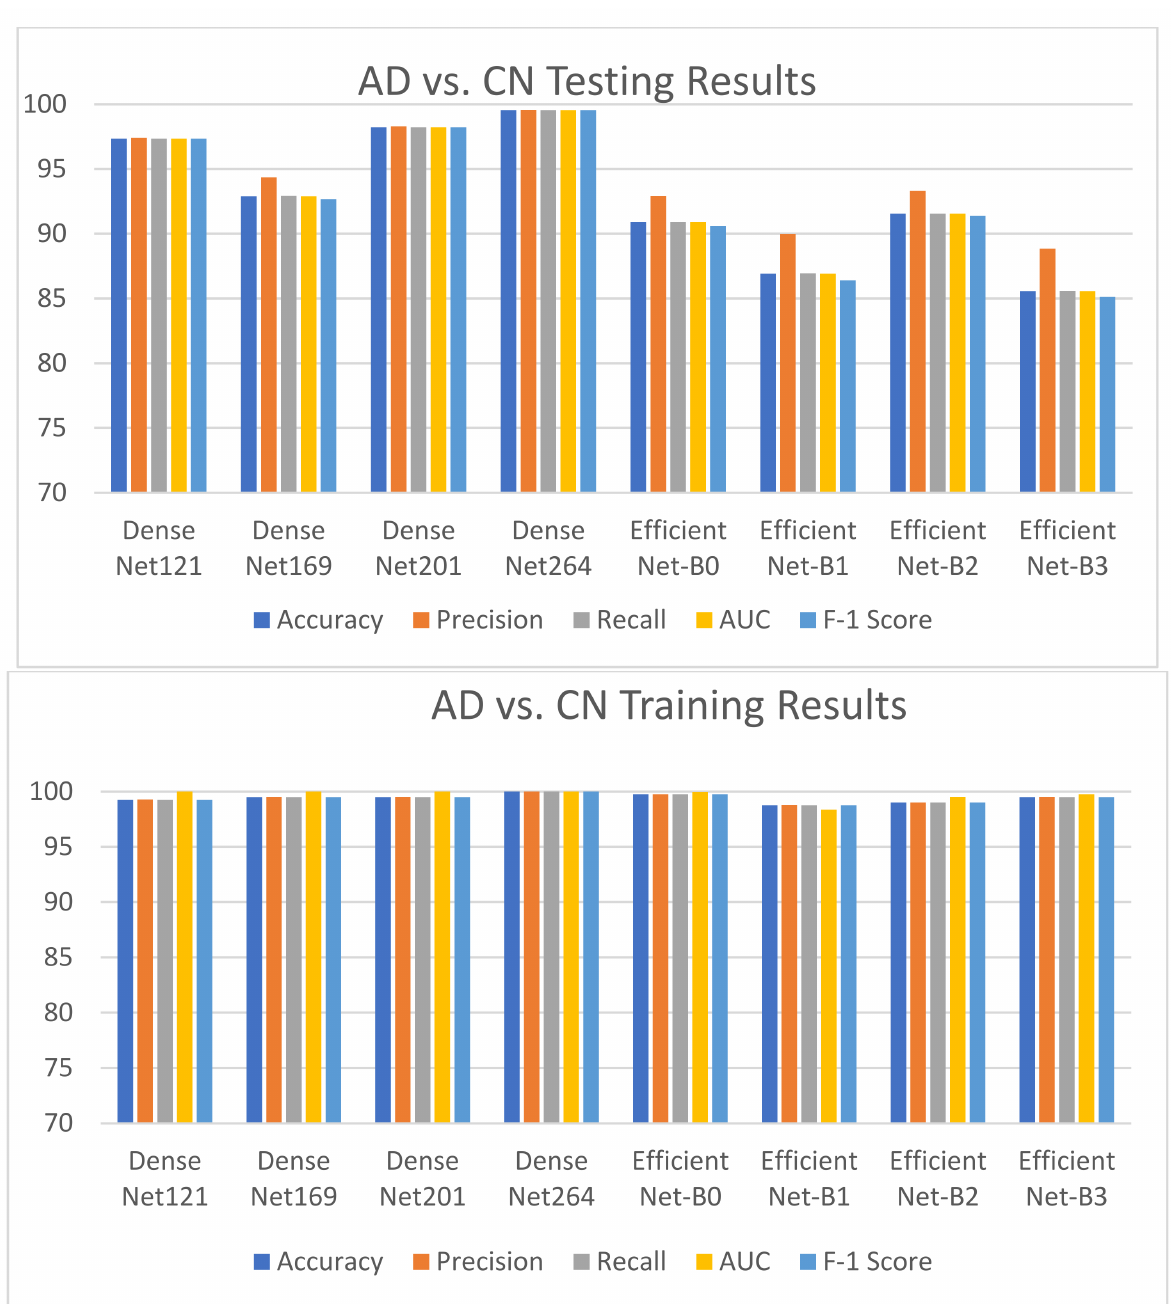
Figure 3. For AD vs. CN classification, the comparison of the results of five evaluation matrices of eight DL models with epoch = 50 and batch size =